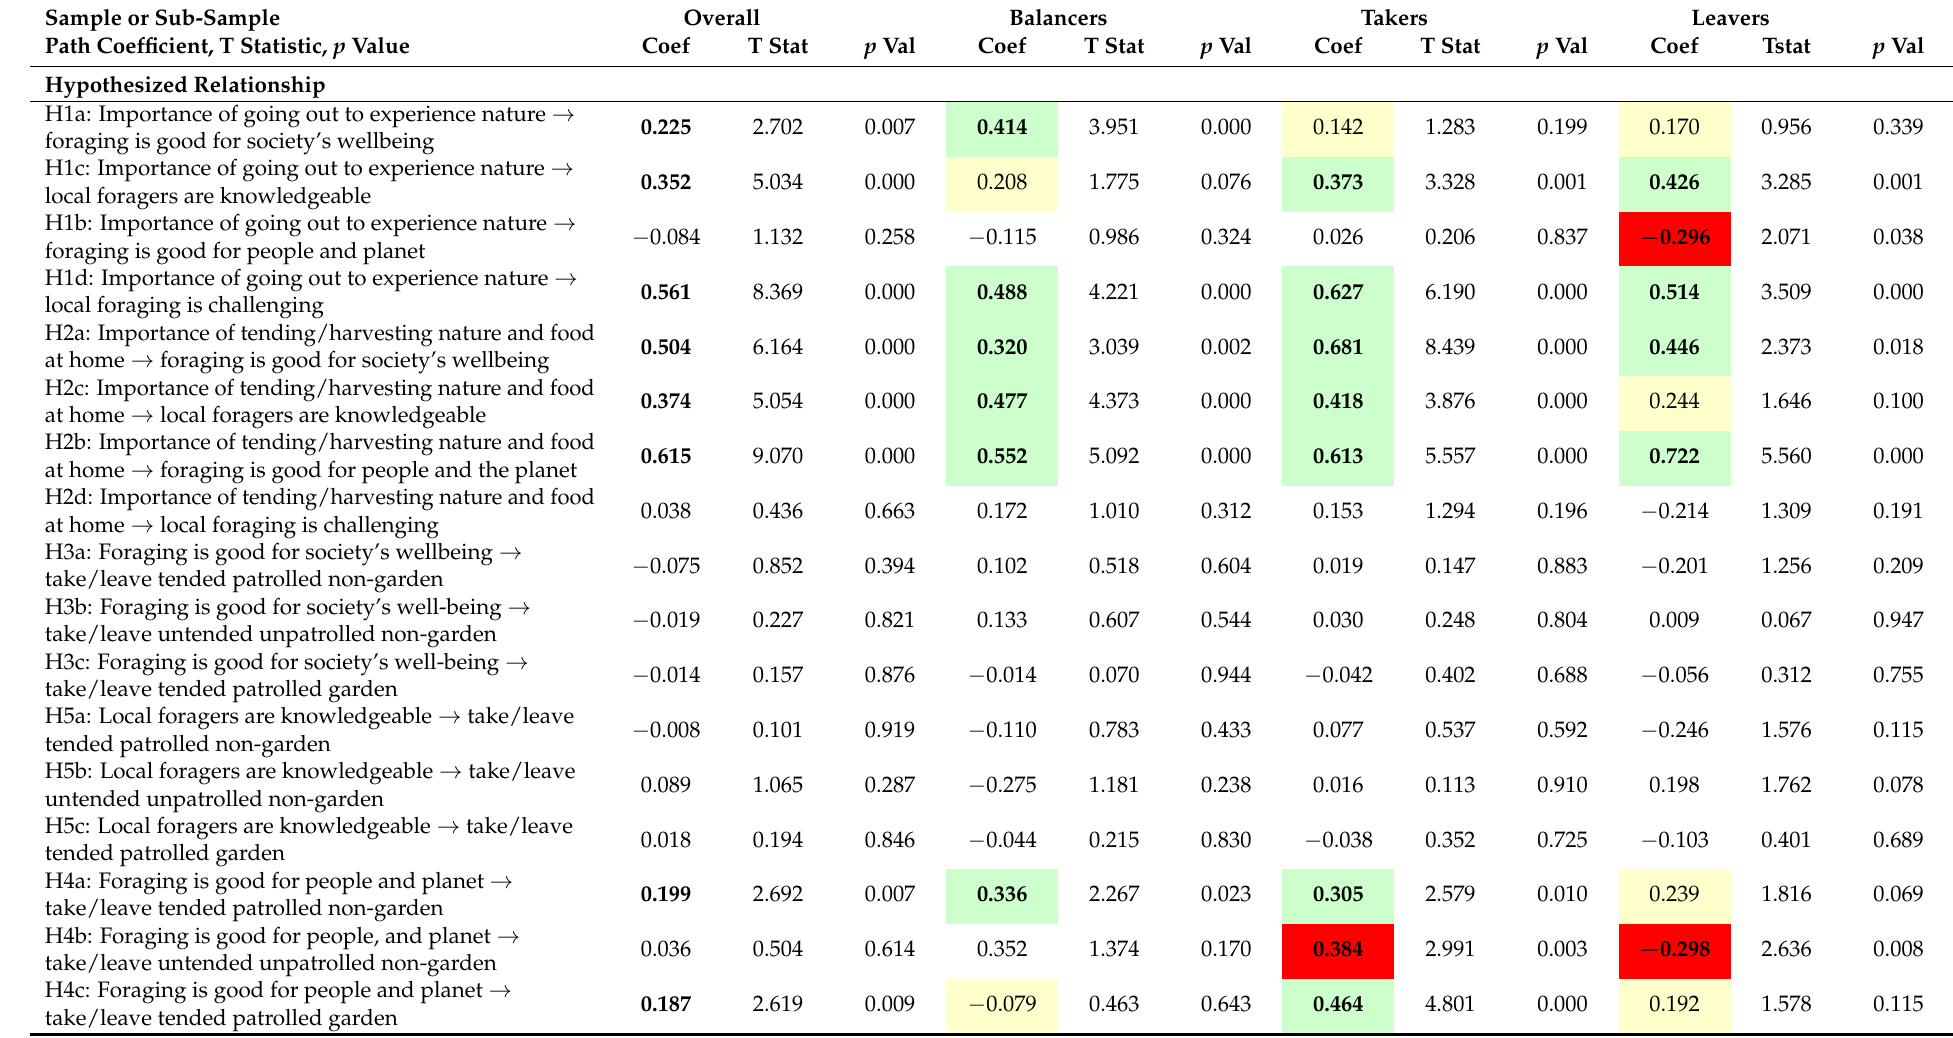
Table 4. Path Coefficients for Overall Sample and